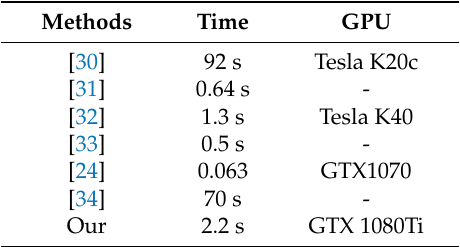
Table 4. Computation time for processing one